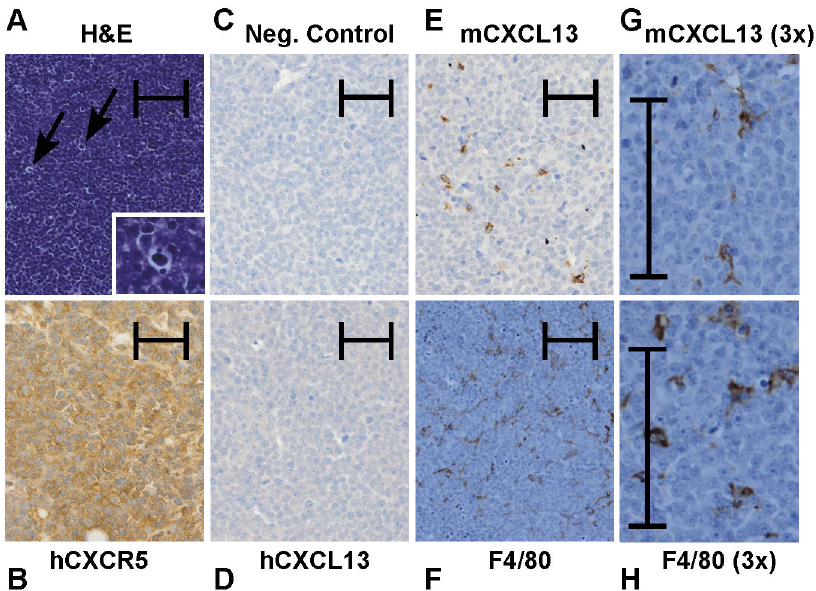
Figure 2. Expression of CXCR5 and CXCL13 on 2F7-derived AIDS-BL tumor cells in NOD-SCID mice, by immunohistochemistry. Immunohistochemistry was performed as described in the Materials and Methods , using an